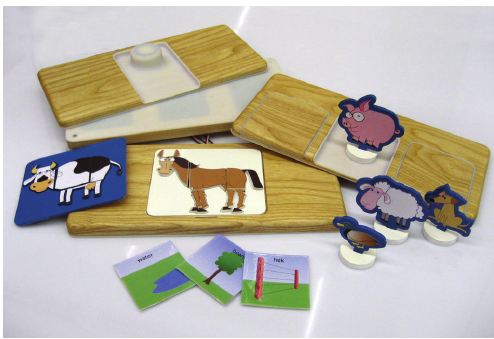
Figure 7: Part of the CLICK-IT